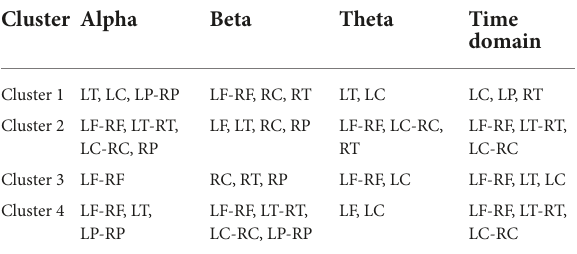
TABLE 4 The brain regions selected from different HO-BFNs. Cluster Alpha Beta Theta Time